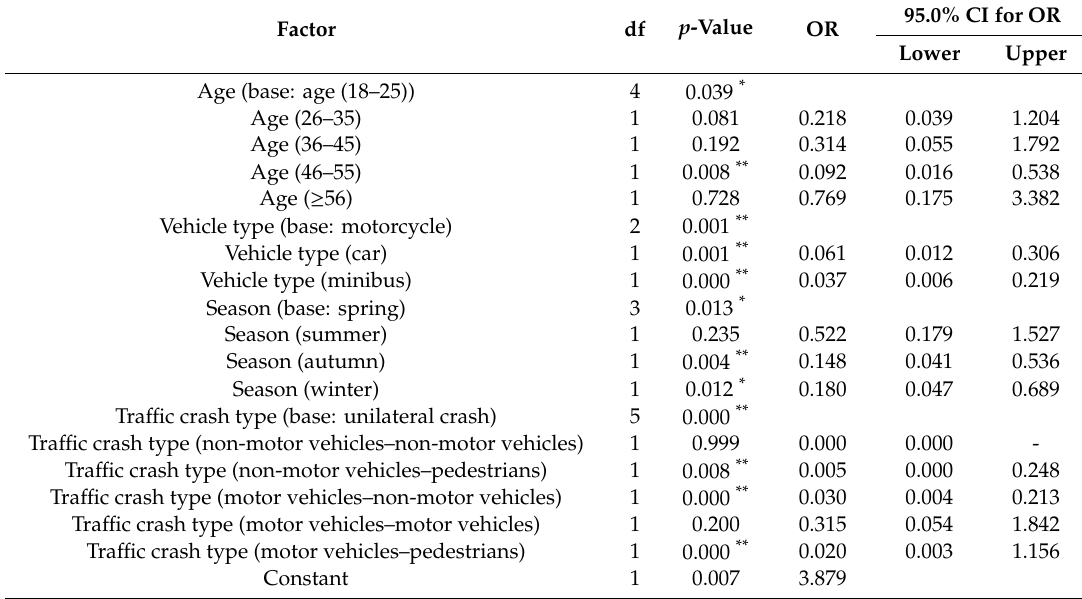
Table 3. Significant factors associated with non-alcohol-related crashes in